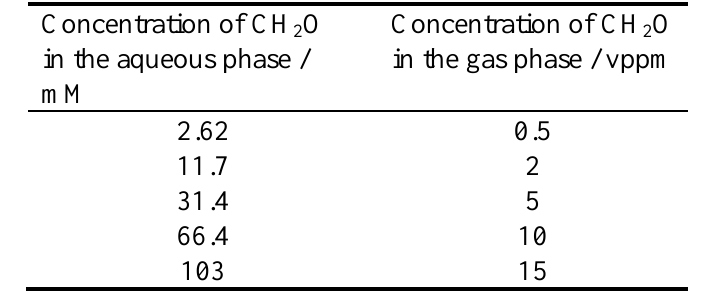
Table 3. Equilibrium gas phase concentrations above an aqueous formaldehyde solution at 20 °C according to equation (2) given by Dong et al.